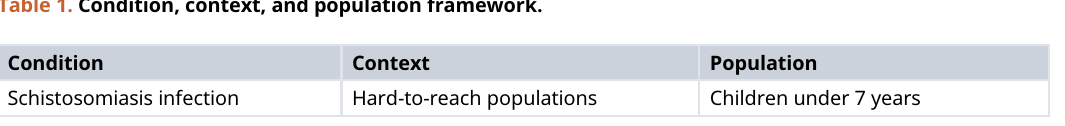
Table 1. Condition, context, and population